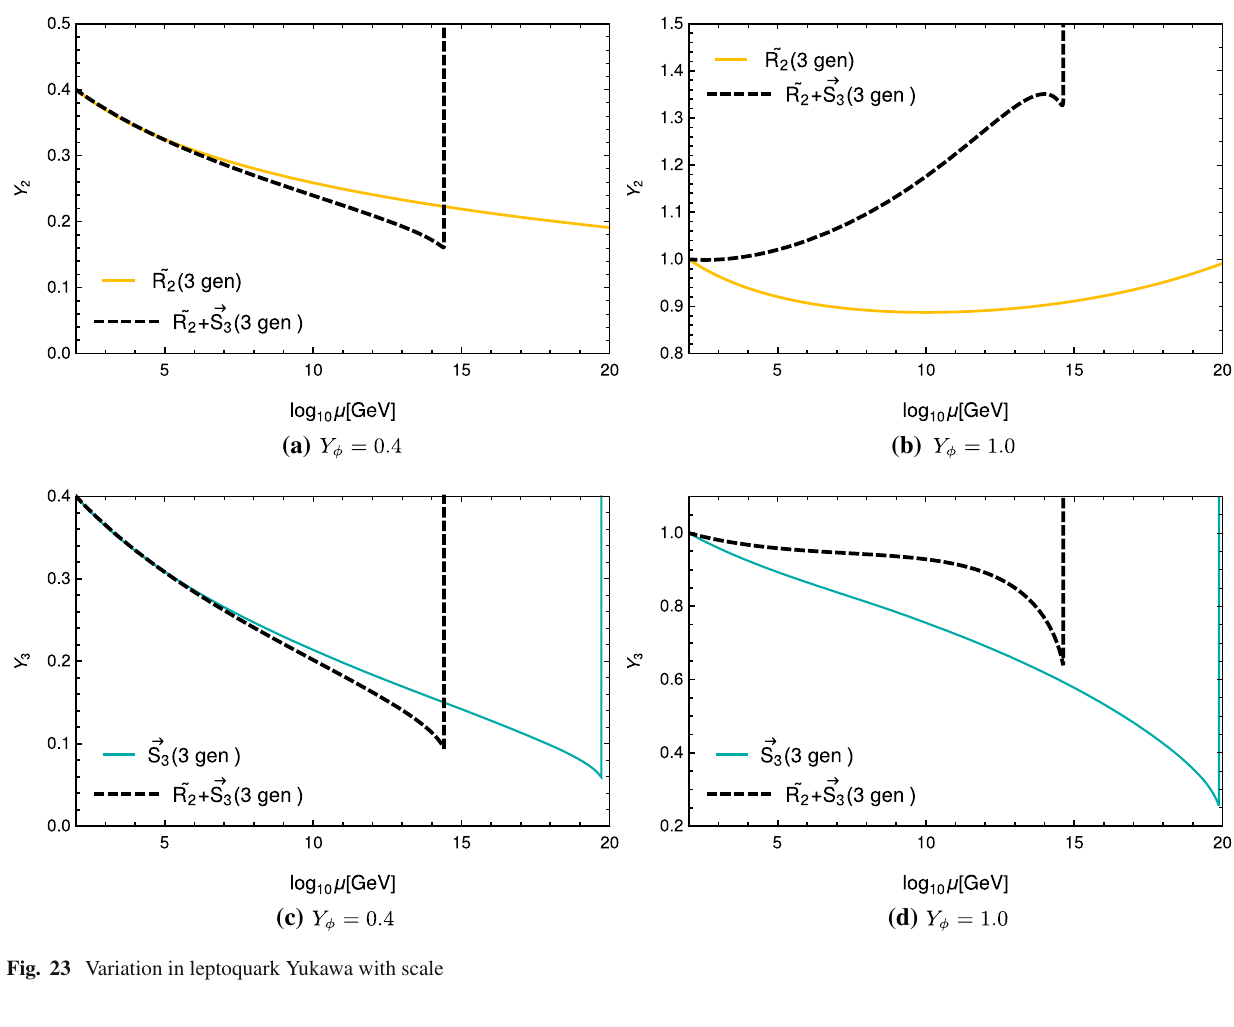
Fig. 23 Variation in leptoquark Yukawa with scale